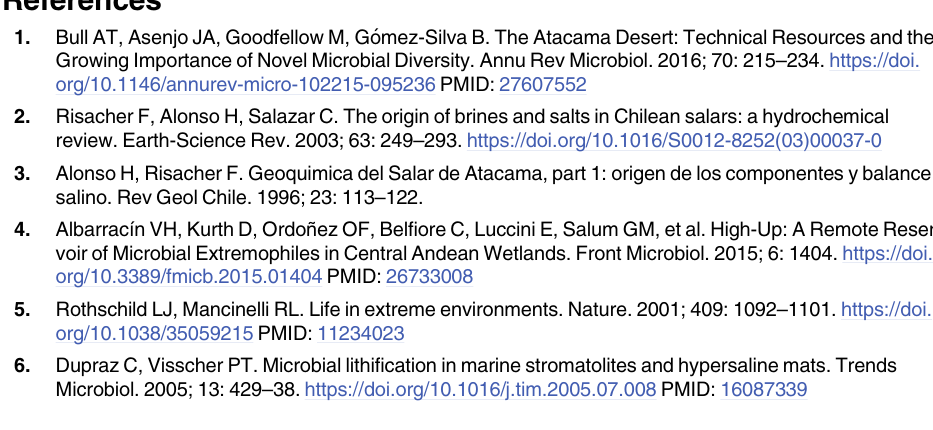
S3 Fig. Clustering of metagenomes from different environments based on phylum abun- dances. (TIF) S4 Fig. Phylum abundances for high altitude Andean metagenomes. (TIF) S1 File.